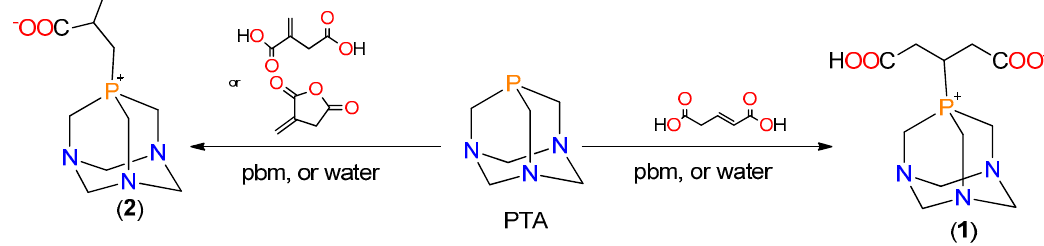
Figure 3. Synthesis of 1 and 2 in water or in a planetary ball mill (pbm).